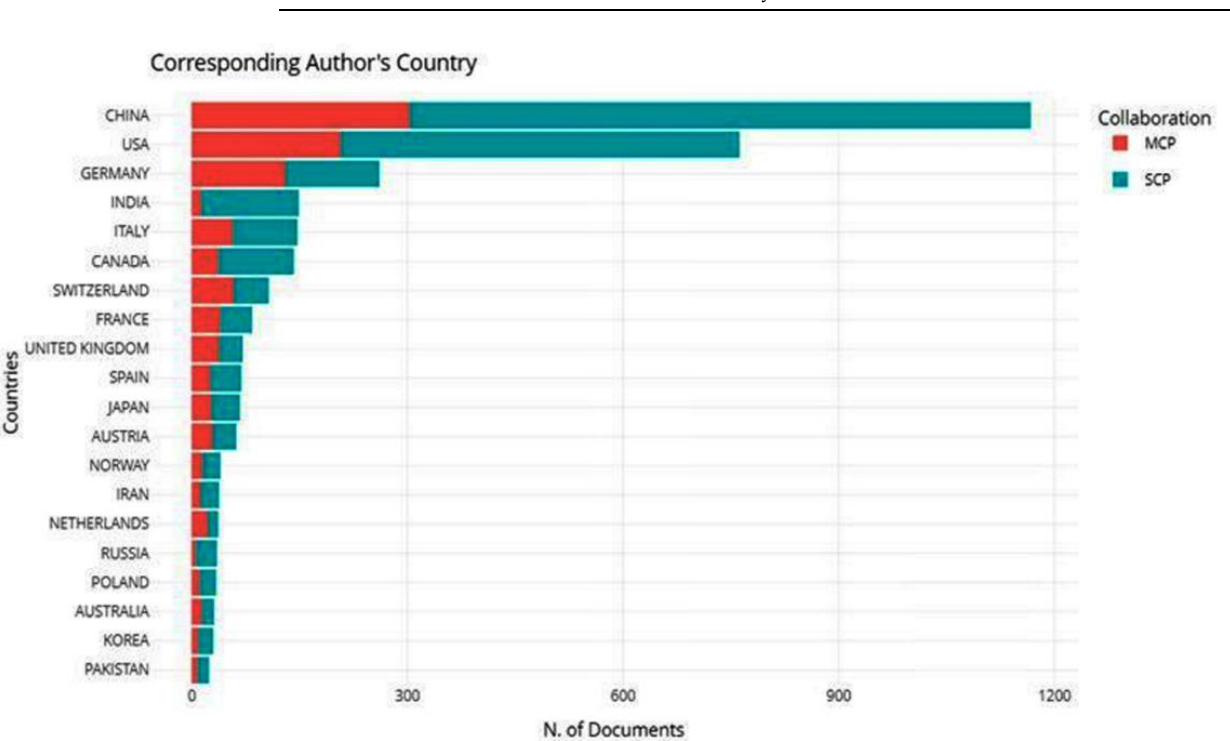
Figure 2. Top 20 countries publishing articles on the application of remote sensing methods in mountainous environments. The country collaborations are represented as inter-country (MCP) and intra-country (SCP) collaboration indices.